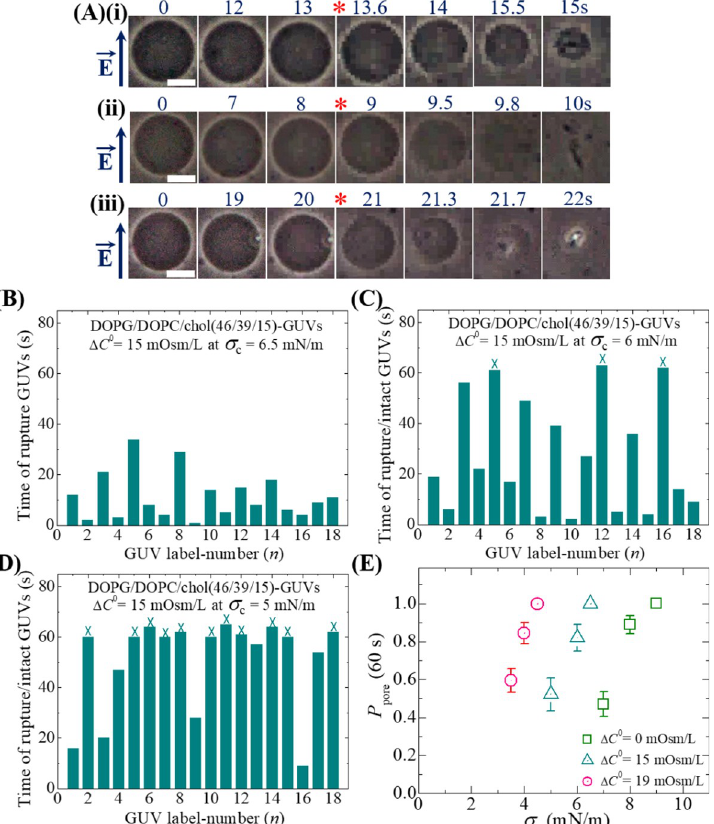
Fig 2. The influence of osmotic pressure on the constant electric tension-induced stochastic rupture of DOPG/ DOPC/chol (46/39/15)-GUVs in a buffer containing physiological ions. (A) Phase contrast images of rupture of (i) first (ii) second and (iii) third ‘single DOPG/DOPC/chol (46/39/15)-GUV’ at tension, σ c = 6.5 mN/m and the osmolarity difference between the inside and outside GUVs, Δ C 0 = 15 mOsm/L. The field direction is shown with an arrow in the left side. The numbers above in each image indicate the time in seconds after applying of σ c due to electric field. The white bar corresponds to a length of 15 μ m. The time of stochastic rupture/intact in several single DOPG/ DOPC/chol (46/39/15)-GUVs under Δ C 0 = 15 mOsm/L at (B) σ c = 6.5 mN/m (C) σ c = 6.0 mN/m and (D) σ c = 5.0 mN/ m. The number of measured GUVs in B, C and D was 18. The bars in B, C, D represent ruptured and intact GUVs. The cross mark ( × ) above the bars in C, D indicates the intact GUVs until time 60 s. (E) The σ c dependent P pore (60 s) value for DOPG/DOPC/chol (46/39/15)-GUVs under Δ C 0 = 0 (green open square), Δ C 0 = 15 mOsm/L (cyan open triangle) and Δ C 0 = 19 mOsm/L (pink open circle). Average values and standard deviations of P pore (60 s) at σ c were determined for 2–3 independent experiments, each with 15–24 GUVs, for each value of σ c . value with standard deviation of rate constant for each tension. Fig 3(B) shows the σ depen- c dent k values for Δ C 0 = 15 mOsm/L (cyan open triangle). Next, we investigated the constant p electric tension-induced rupture of DOPG/DOPC/chol (46/39/15)-GUVs for a different Δ C 0 using the same method. For this purpose, an amount of 20 μ L GUVs suspension was provided into the microchamber containing the same buffer of amount 280 μ L with 72.3 mM glucose concentration. Hence, the outside concentration of DOPG/DOPC/chol (46/39/15)-GUVs was 74 mM, which had osmolarity value C = 369 mOsm/L. The osmolarity difference between out the inside sucrose and the outside glucose concentration of GUVs was Δ C 0 = 388–369 = 19 mOsm/L. Using the similar procedure, we calculated the values of k under Δ C 0 = 19 mOsm/L p at tensions 4.5, 4.0 and 3.5 mN/m. The σ dependent k value for Δ C 0 = 19 mOsm/L (pink c p open circle) is shown in Fig 3(B).